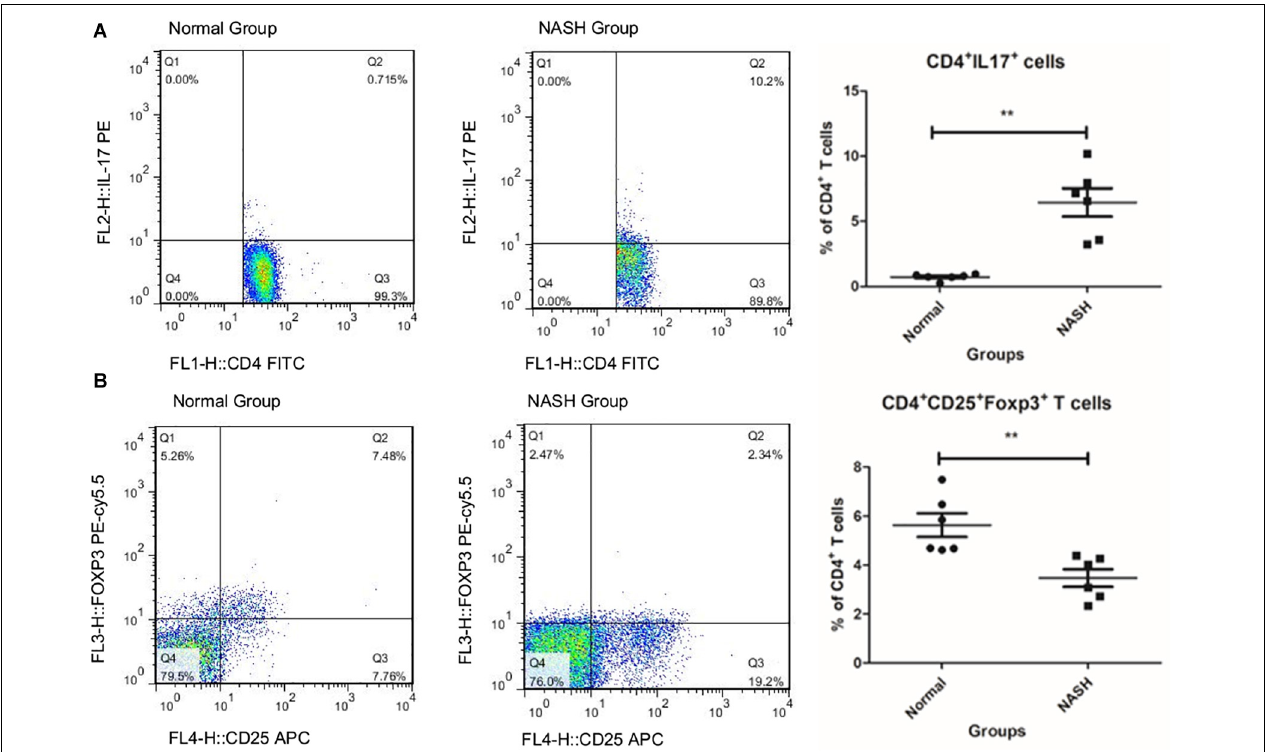
FIGURE 1 | TH17 and Treg cell levels measured by flow cytometry. (A) Represents the ratio of TH17 to CD4+T in groups by flow cytometry analysis. (B) Displays the ratio of Treg cell to total CD4+T in groups ** P <